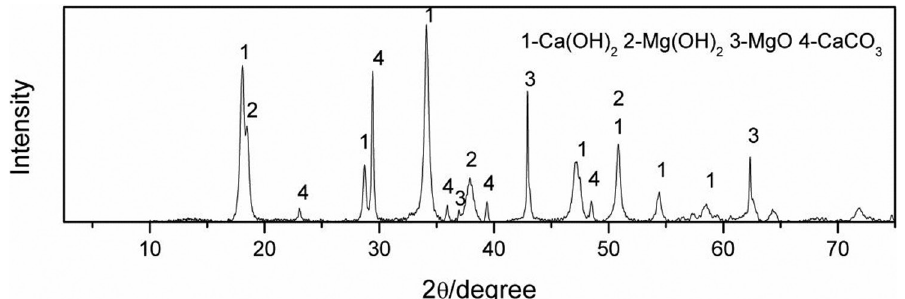
Figure 2: The X-ray diffraction results of calcined